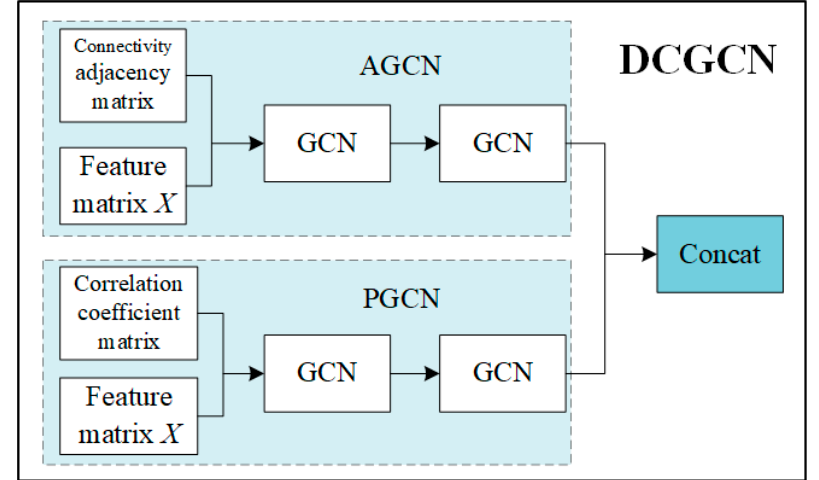
Figure 4. Diagram of the DCGCN model results.